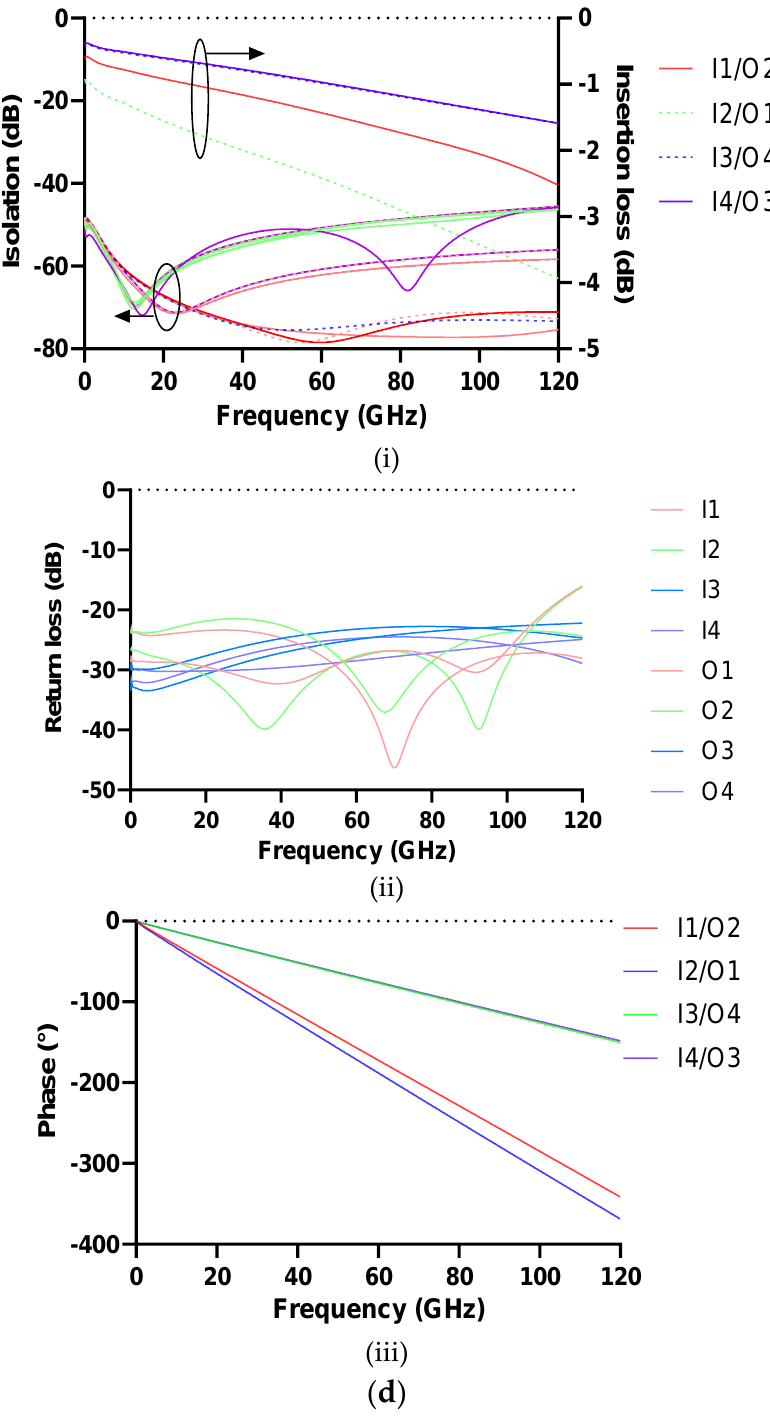
Figure 8. ( a ) Simulated HFSS model of the 4 × 4 staircase PCM-based switch matrix, ( b ) the 4 sets of configurations covering all the possible connections of, ( c ) set 1 with (i) showing the insertion losses of the connected paths and isolations between the disconnected ports, (ii) the return losses at all ports and (iii) the connected paths’ phases and ( d ) set 2 RF performances with (i) showing the insertion losses of the connected paths and isolations between the disconnected ports, (ii) the return losses at all ports and (iii) the connected paths’ phases. It should be noted that no legends are included for the port-to-port isolations due to the large number of disconnected ports.